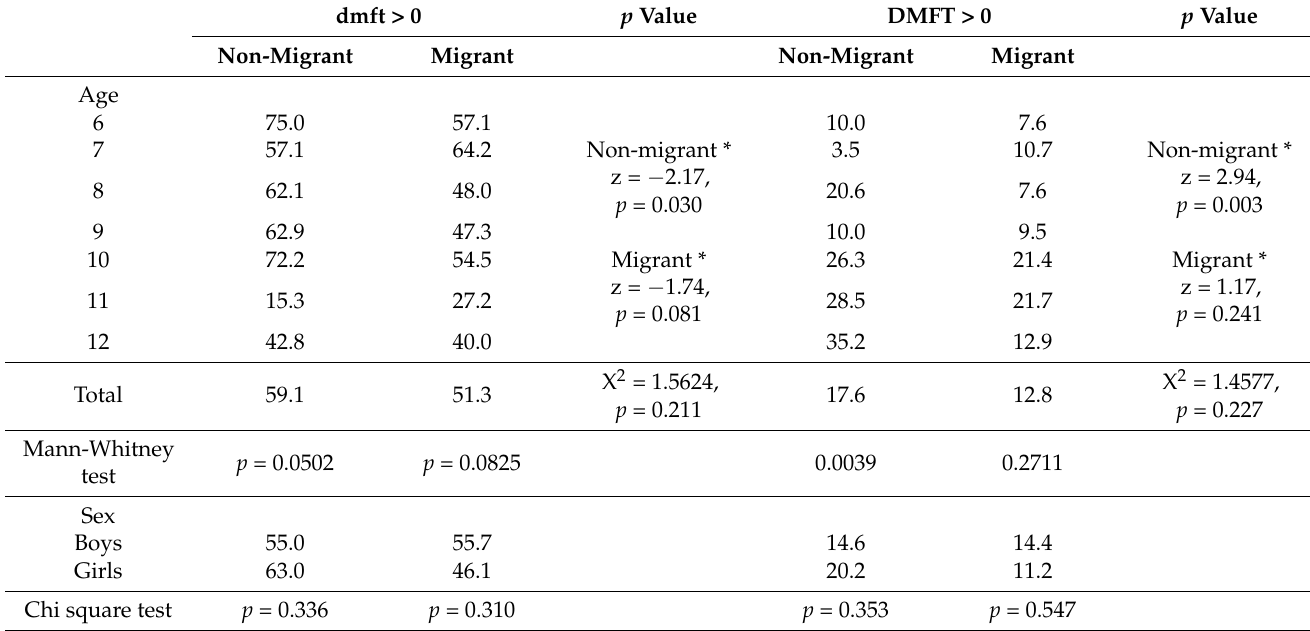
Table 4. Caries prevalence in primary and permanent teeth by age group and sex in the migrant and non-migrant